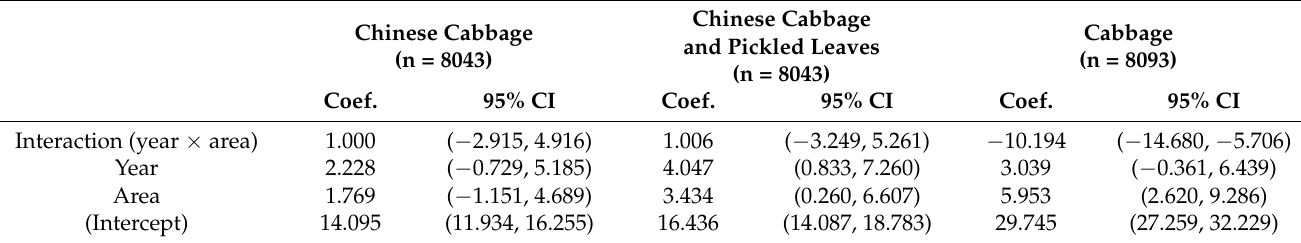
Table 2. Confirmation of parallel trends.